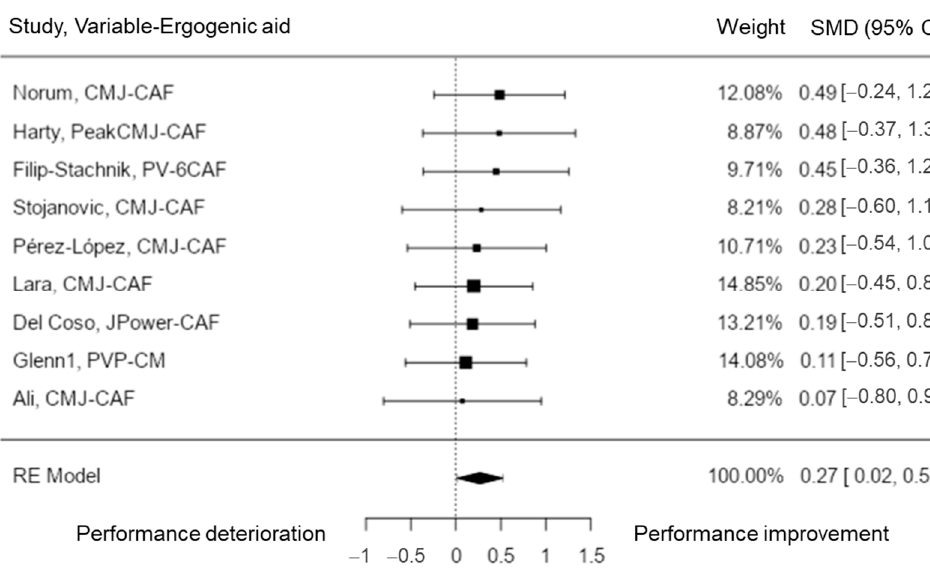
Figure 2. Power and jumping performance forest plot. CMJ = counter movement jump; PV = peak velocity; JPower = jumping power; PVP = peak vertical power.